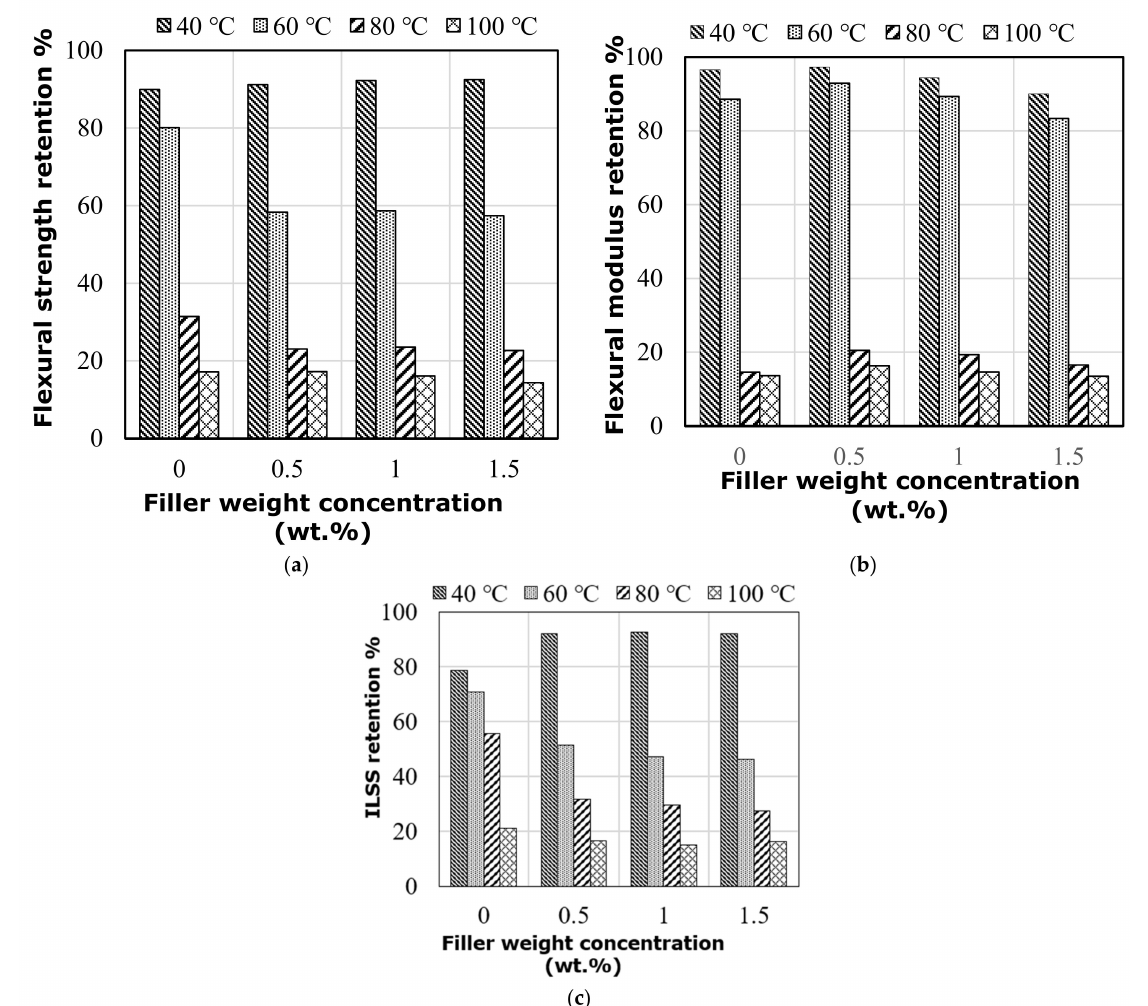
Figure 8. Property retention of the tested specimens at elevated temperature: ( a ) flexural strength retention; ( b ) flexural modulus retention; ( c ) interlaminar shear strength